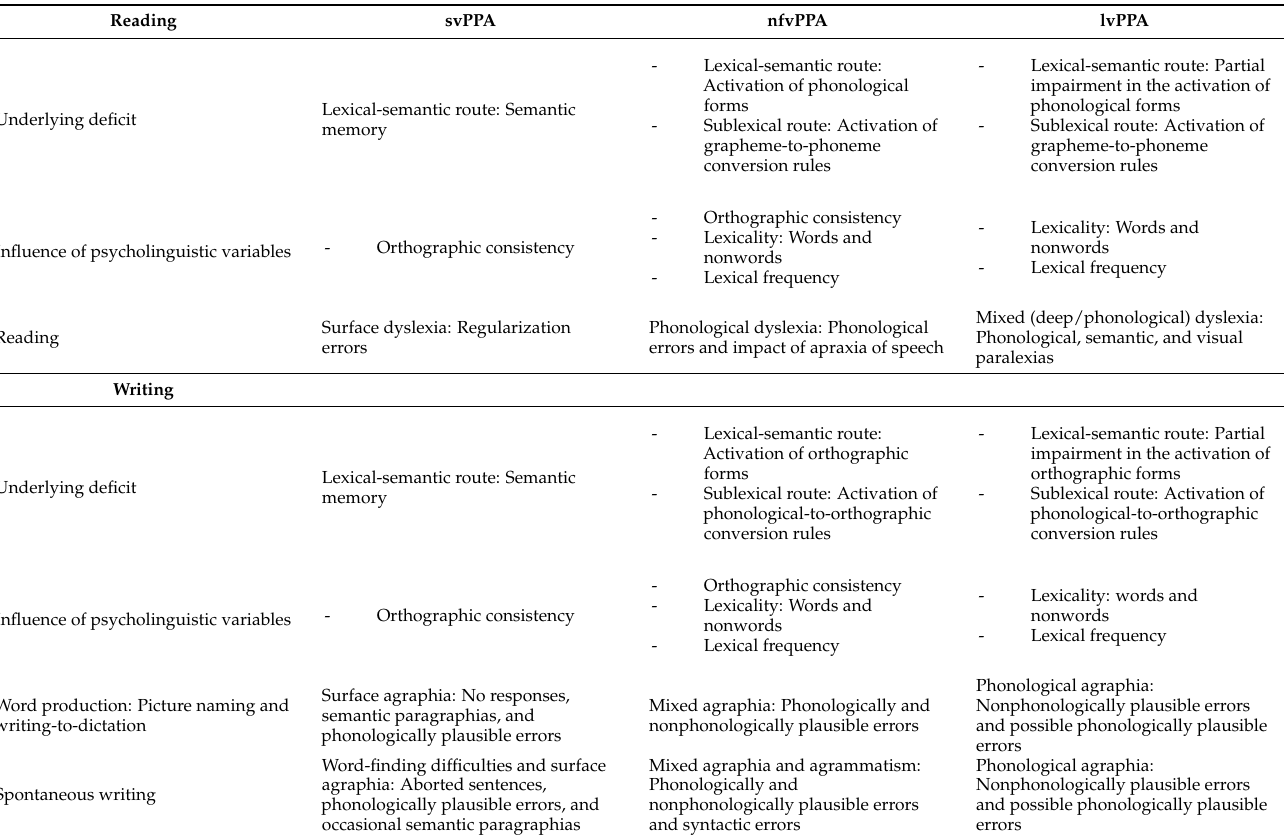
Table 3. Underlying cognitive deficits and salient characteristics of written language disorders in the three PPA variants.